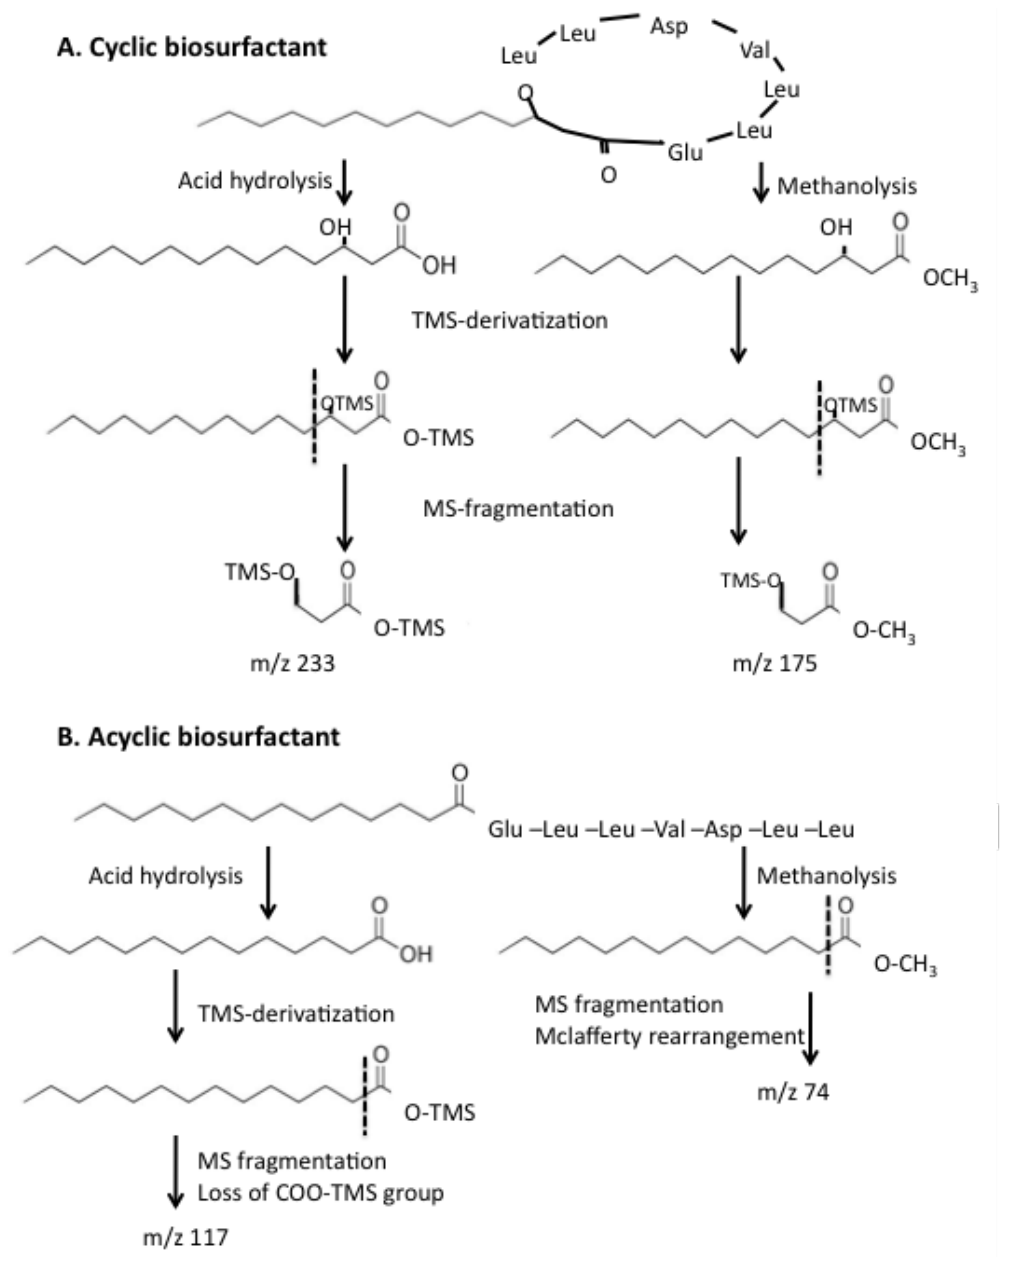
Figure 2. Summary of the outcome of acid hydrolysis and methanolysis of ( A ) a cyclic lipopeptide biosurfactant, and ( B ) an acyclic (linear) lipopeptide biosurfactant. Each type of biosurfactant was either acid hydrolyzed or methanolyzed (as described in text) with the release of a free fatty acid, or a fatty acid methyl ester (FAME), respectively. The fatty acid and FAME were then derivatized, separated by gas chromatography, and identified by mass spectrometry. Dotted line refers to the fragmentation pattern of the mass ion used to extract the MS chromatogram as explained in